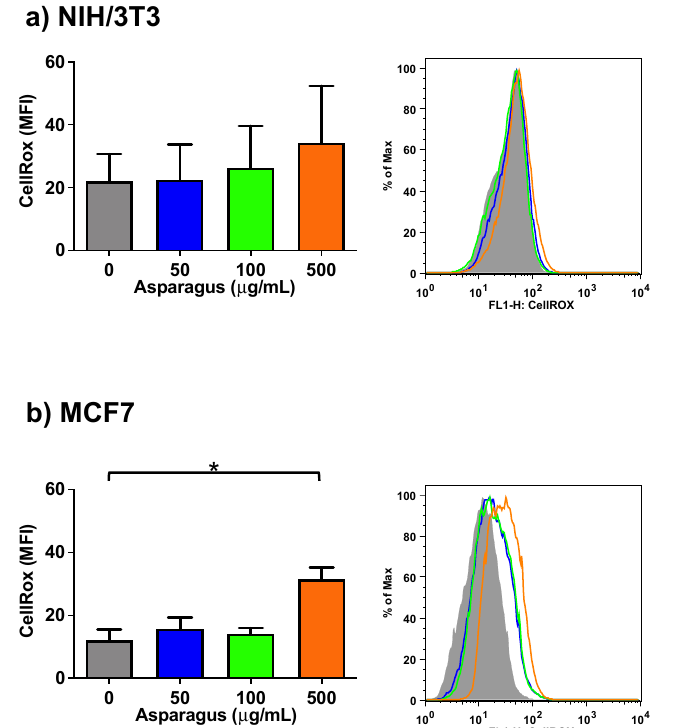
Figure 5. NIH-3T3 ( a ) or MCF7 ( b ) cells were treated with 0, 50, 100 or 500 µ g/mL of Asp extracts for 48 h and incubated with CellROX Green Reagent to investigate the oxidation level (stress) of the cells. Left panels: MFI data are reported as mean ± standard error of results from three independent experiments; right panels: super imposed graphs from flow cytometry dot plots data of a representative experiment. The axes scale for fluorescence is reported as logarithmic. Statistical analyses were performed by ANOVA followed by Bonferroni’s post hoc test. * p < 0.05. As expected, cells treated only with Menadione (positive control) showed a signif- icant increase in oxidant production compared to untreated cells ( p -value 0.0425 and p -value ≤ 0.0001 for NIH/3T3 and MCF7, respectively). Interestingly, cells